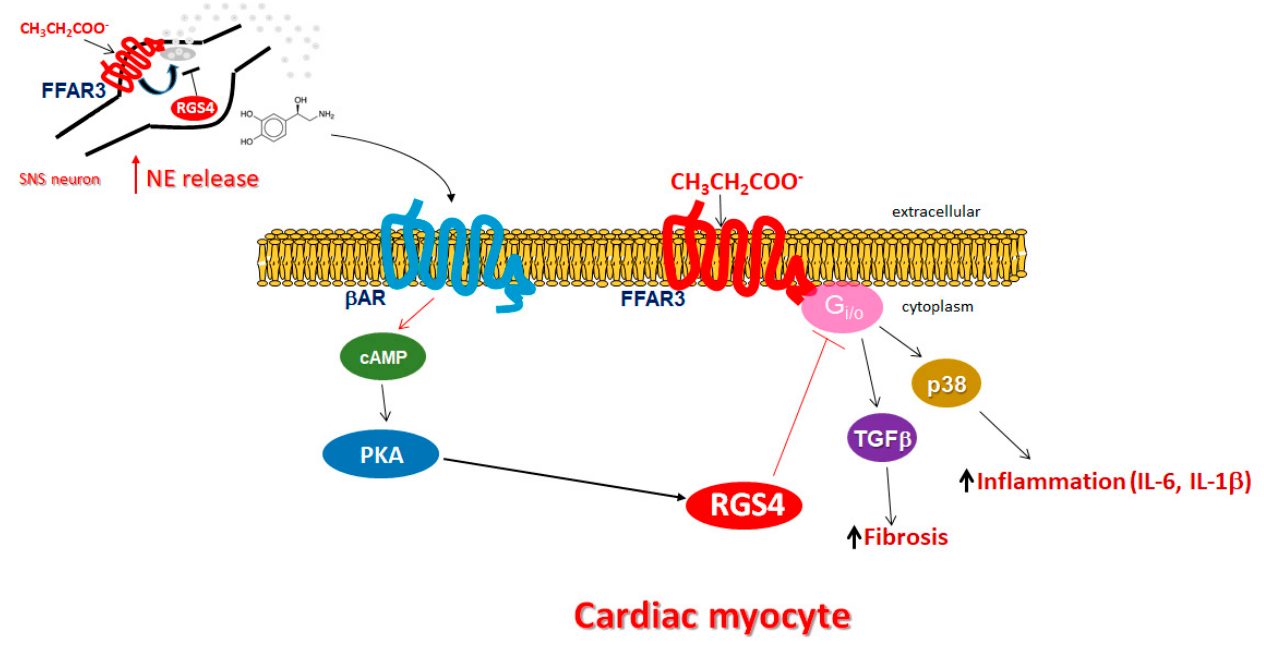
Figure 5. Schematic illustration of propionic acid-activated FFAR3 signaling and function in cardiac myocytes and in sympathetic neurons, and the inhibitory role of RGS4 in both tissues. See text for details. SNS: Sympathetic nervous system.